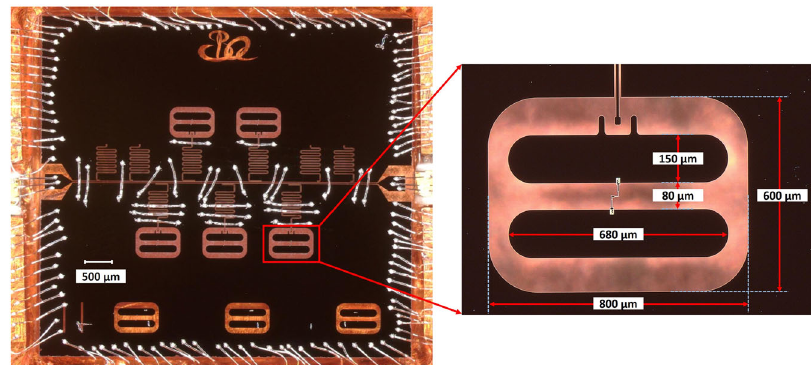
Fig. 4 An optical micrograph of a packaged transmon sample with Ta fi lm. The size of the chip is 7 mm. It contains fi ve independent transmons, four independent quarter-wave resonators for measuring the intrinsic Q factor of the resonator, and three transmons for the resistance test. Purcell limit of transmon design is over 2 milliseconds. The coupling strength between the readout resonator and transmon is 50 MHz × 2 π (experimental values are close to the design values). The dimensions in the enlarged photo are design values.